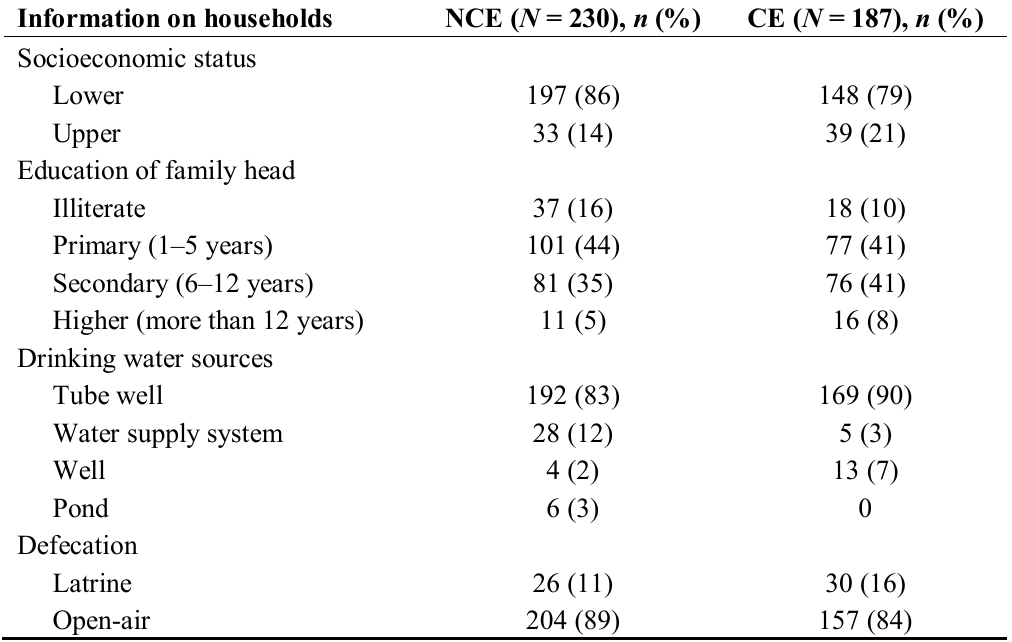
Table 2. Households’ characteristics and E. coli isolation rate from various sources in non-coastal and coastal